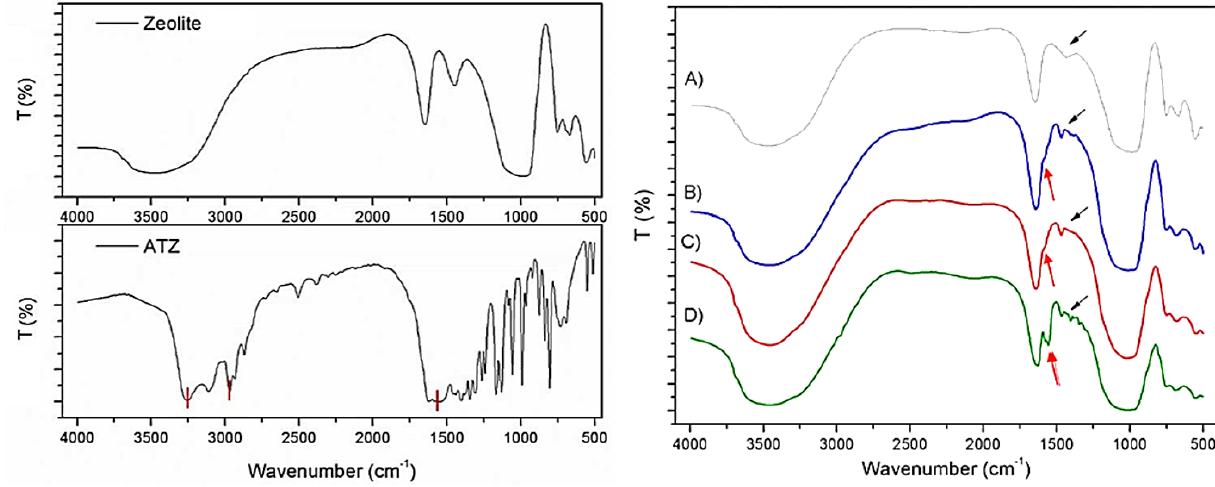
Figure 8. FTIR spectra of the starting 13X zeolite and atrazine ( left ) and of zeolite samples obtained after batch and reactor experiments ( right ): (A) permeable barrier reactor; (B) biosorption by bacte- ria/zeolite; (C) biosorption by adapted biofilm/zeolite; (D) adsorption with zeolite. Black and red arrows indicate bands centered at 1300 cm -1 and 1550 cm -1 , respectively.